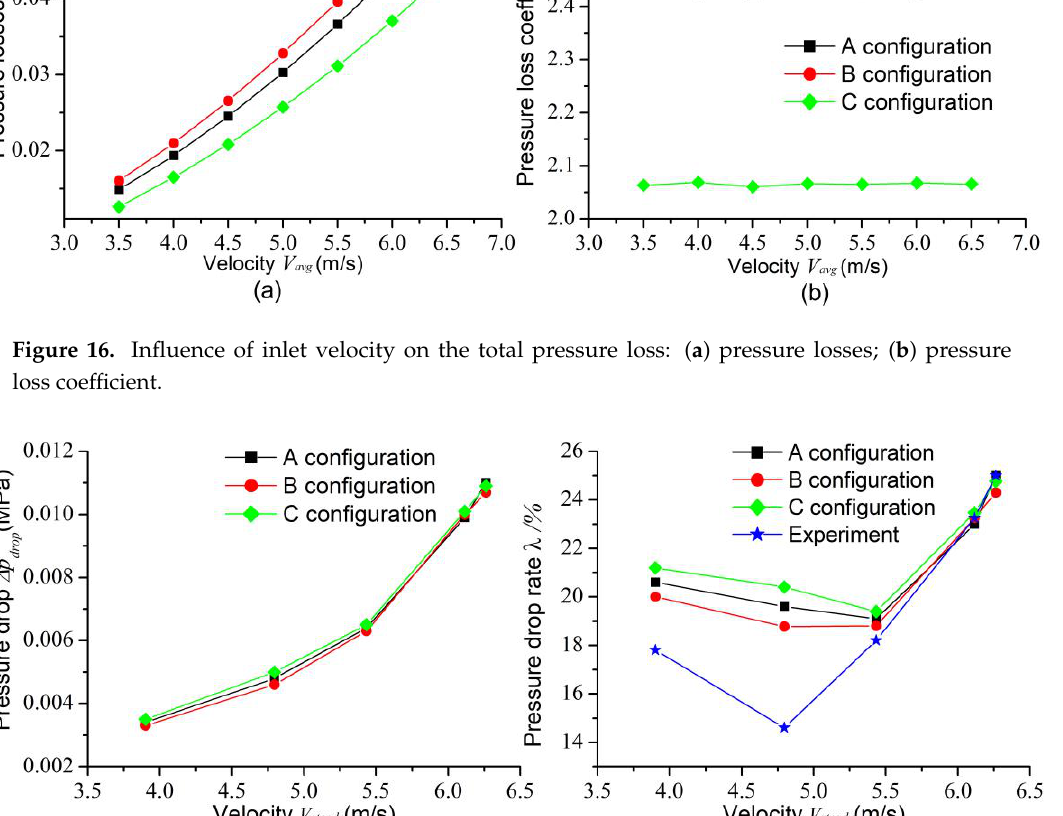
Figure 16. Influence of inlet velocity on the total pressure loss: ( a ) pressure losses; ( b ) pressure loss coefficient.